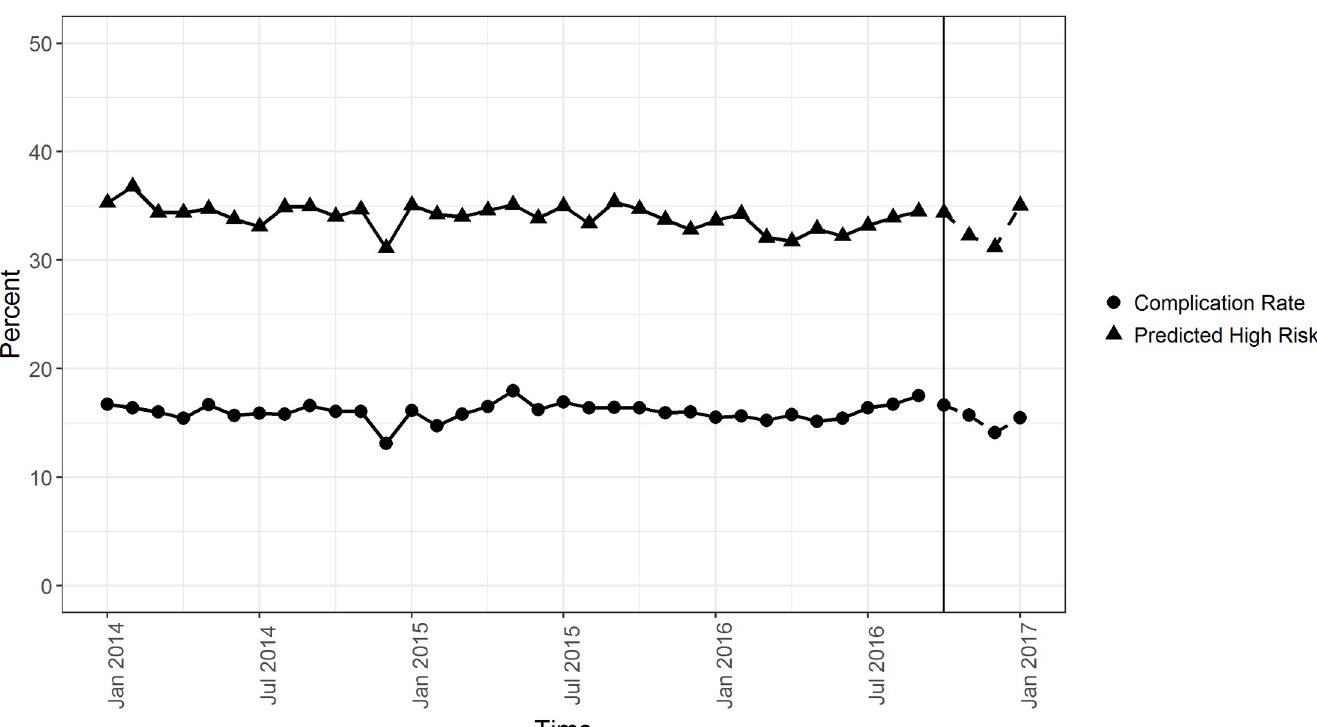
Fig 4. Predicted 30-day complication rate based on lasso model versus observed complication rates. January 2014–September 2016 shows predicted complication rates of the training data, and October 2016–January 2017 displays projected complication rates based on a non-random, out-of-sample test set from a different time period. lasso, least absolute shrinkage and selection